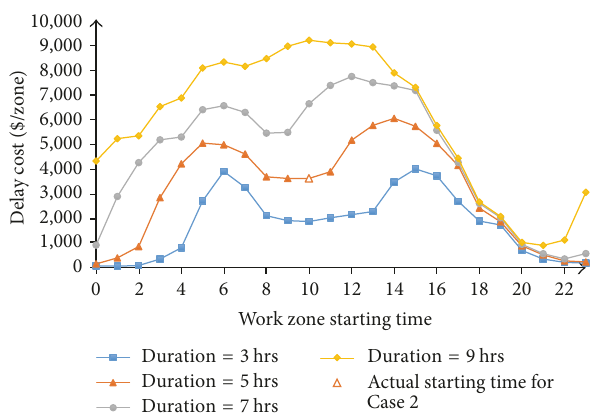
Figure 4: Predicted delay costs versus starting time for various work zone durations (Case